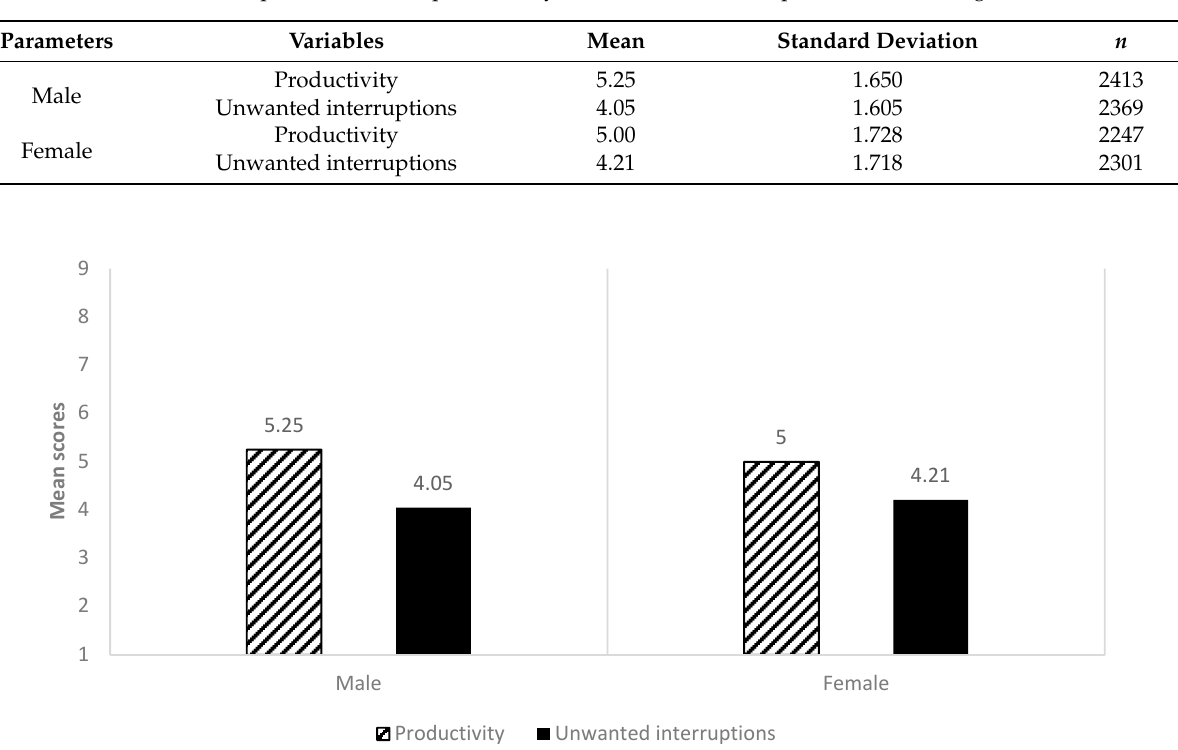
Table 13. Descriptive statistics of productivity and unwanted interruptions for different genders.